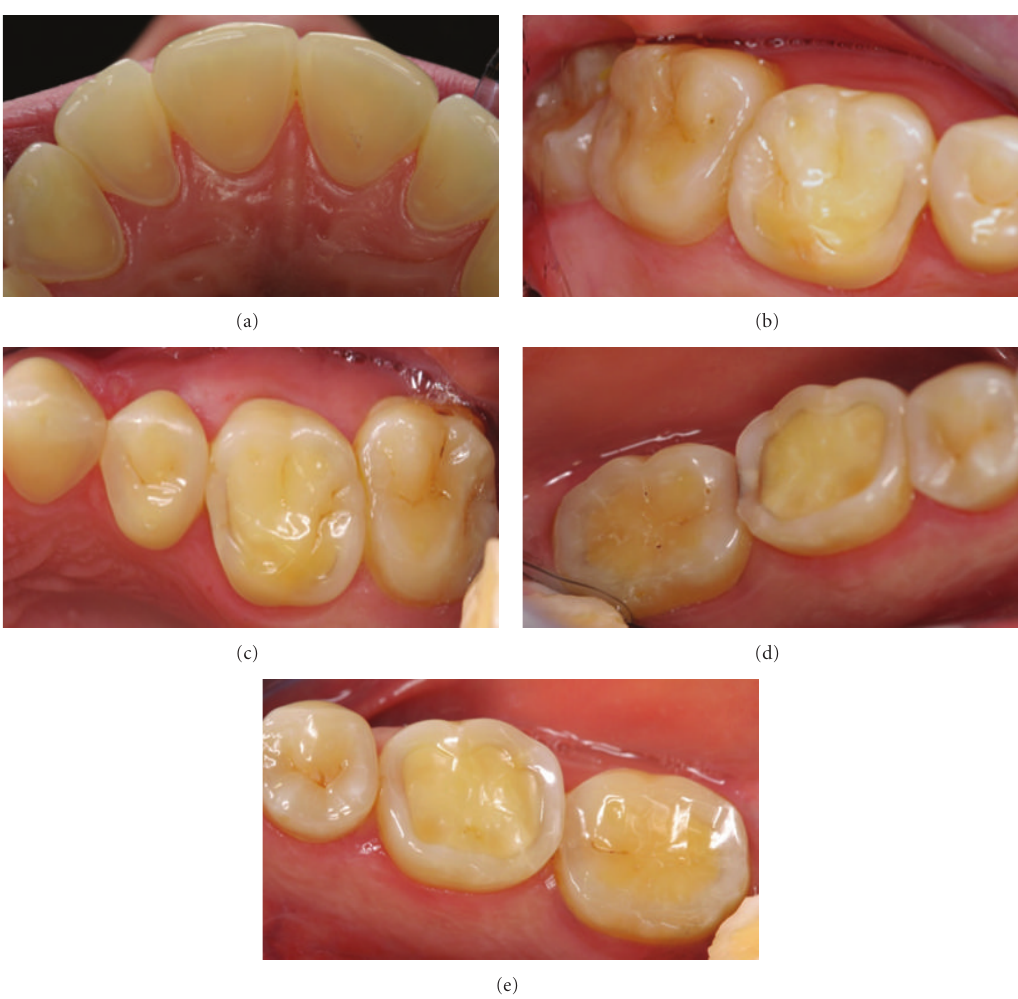
Figure 1: Clinical photographs of the patient case: A 28-year-old woman who had an eating disorder with vomiting as a teenager, but is now healthy. (a) palatal surfaces of the upper incisors, (b) occlusal surfaces of upper right 1st and 2nd molars, (c) occlusal surfaces of upper left 1st and 2nd molars, (d) occlusal surfaces of lower right 1st and 2nd molars, and (e) occlusal surfaces of lower left 1st and 2nd